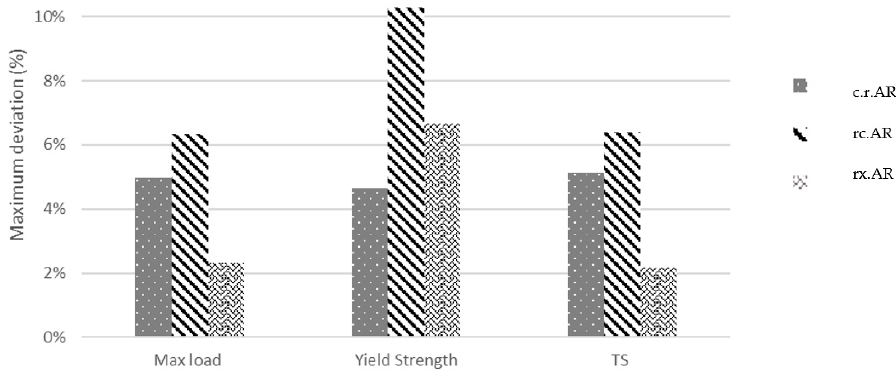
Figure 4. Maximum deviation of the mechanical properties for each sample. Figure 3. Conductivity vs. Hardness diagram of the three states examined (cold ‐ rolled, recovered, and recrystallized).